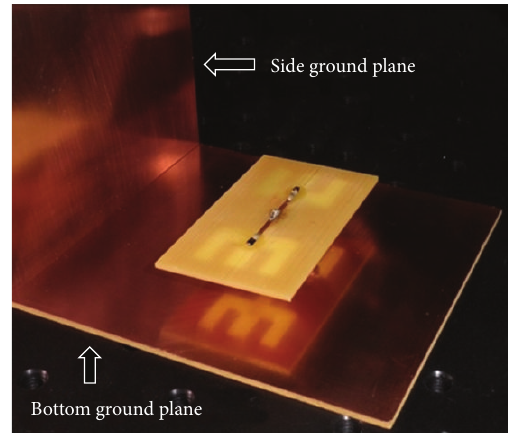
Figure 7: Photograph of antenna array with a corner reflector.